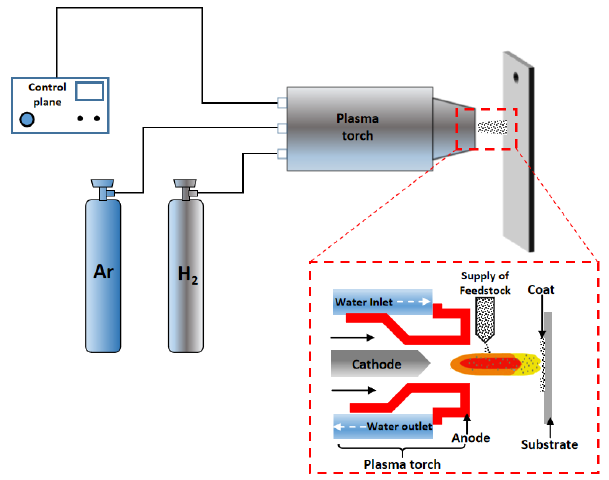
Figure 4. Schematic diagram of plasma spraying coating preparation.